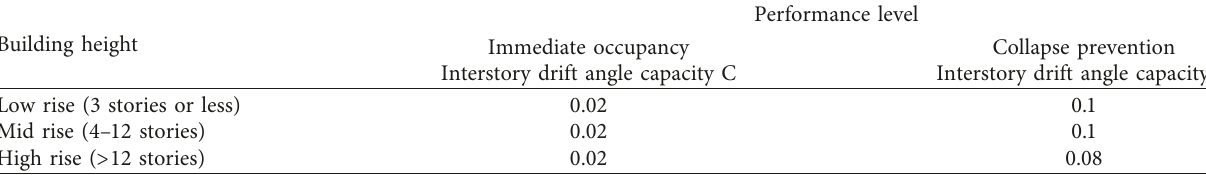
Table 7: Global interstory drift angle capacity C for regular SMF [21].